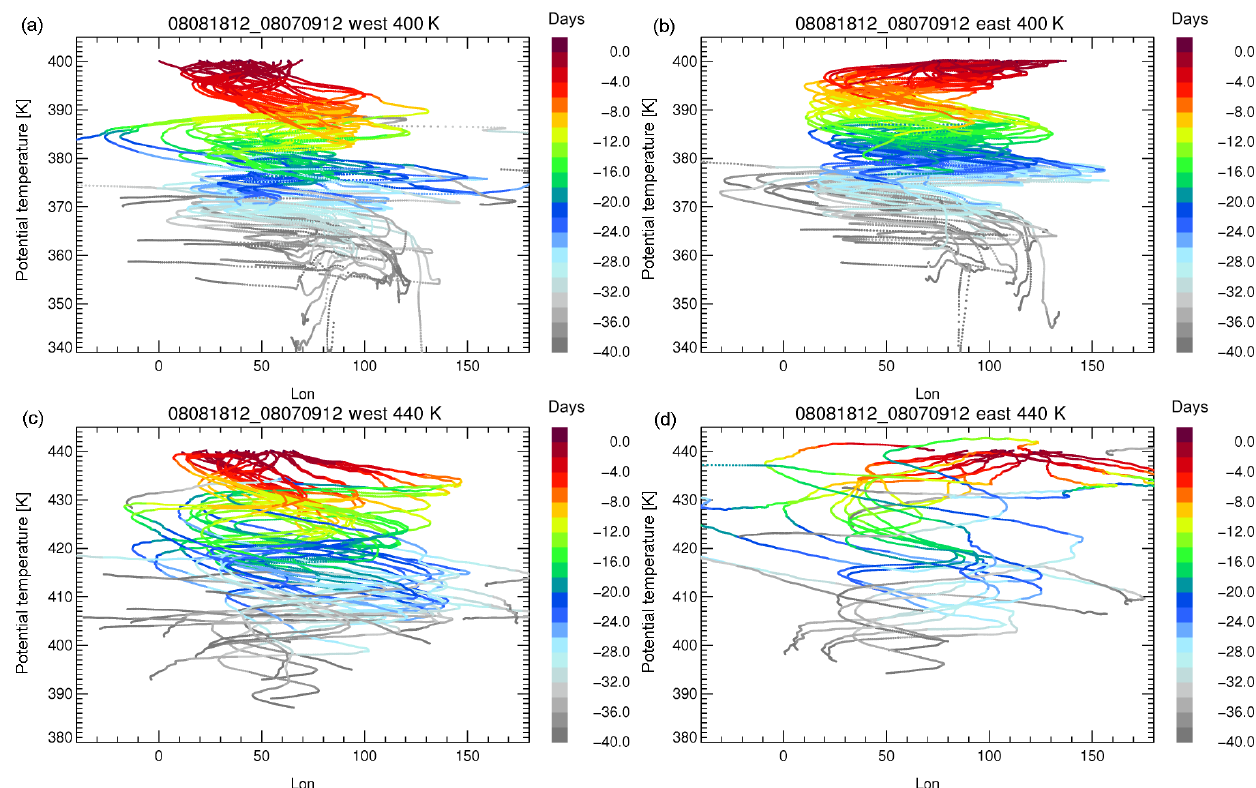
Figure 7. Potential temperature of different 40-day backward trajectories started at 400K (a, b) and 440K (c, d) in the western (a, c) and eastern (b, d) mode of the Asian monsoon anticyclone are shown versus longitude, colour-coded by days back from 18 August